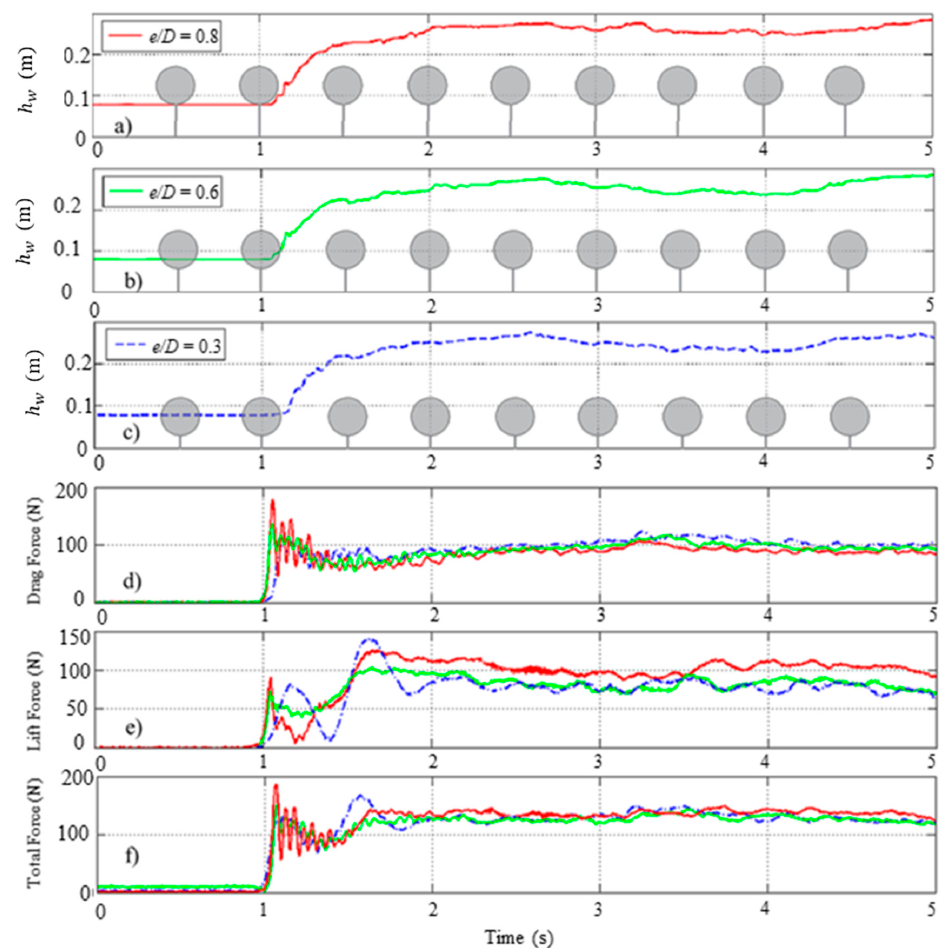
Figure 8. Time-history of the water level and force component measurements at WG1 for the wet bed condition, impoundment depth h = 40 cm, still water depth d = 8 cm, and d / h = 0.2: ( a ) water level for e / D = 0.8 and S / D = 0, ( b ) water level for e / D = 0.6 and S / D = 0.2, ( c ) water level for e / D = 0.3 and S / D = 0.5, ( d ) drag force time-history for e / D = 0.3, 0.6, and 0.8, ( e ) lift force time-history for e / D = 0.3, 0.6, and 0.8, and ( f ) total force for e / D = 0.3, 0.6, and